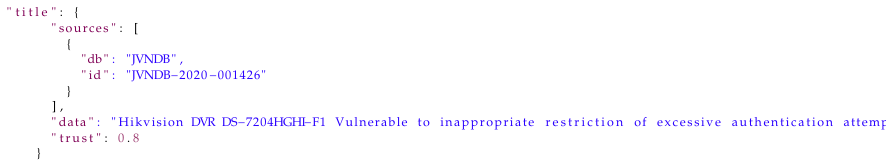
Listing 6. Example of the ”title” field from the high database